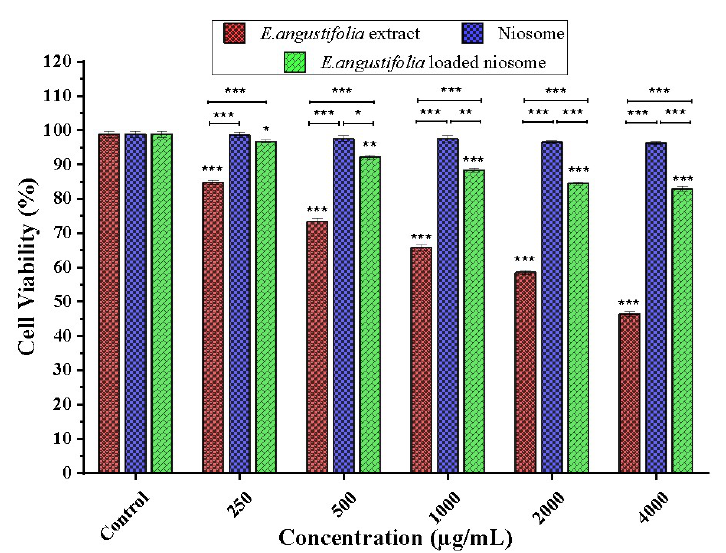
Figure 4. Cytotoxicity of various concentrations of E. angustifolia extract and E. angustifolia -loaded niosome against HFF normal cells within 72 h. The viable HFF cells subjected to distilled water were used as controls and set as 100%. The cytotoxic cut-off was set to 70% viable cells, i.e., a lethal dose of 30%. N = 3. ***: p < 0.001, **: p < 0.01, *: p < 0.05.